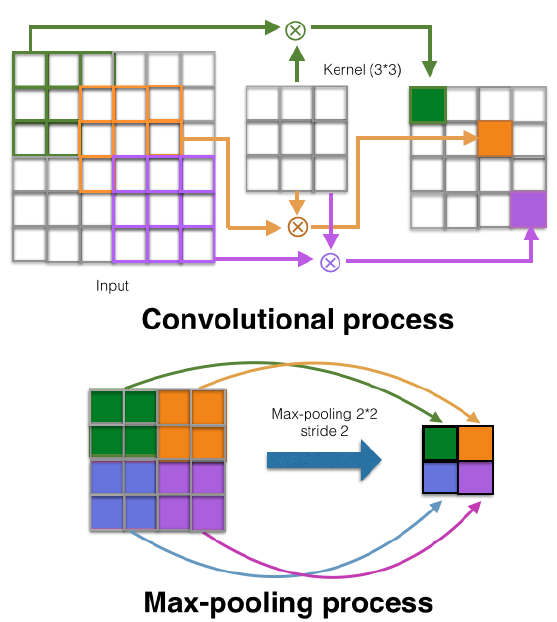
Figure 6. Convolution and Max-pooling process, image adapted from